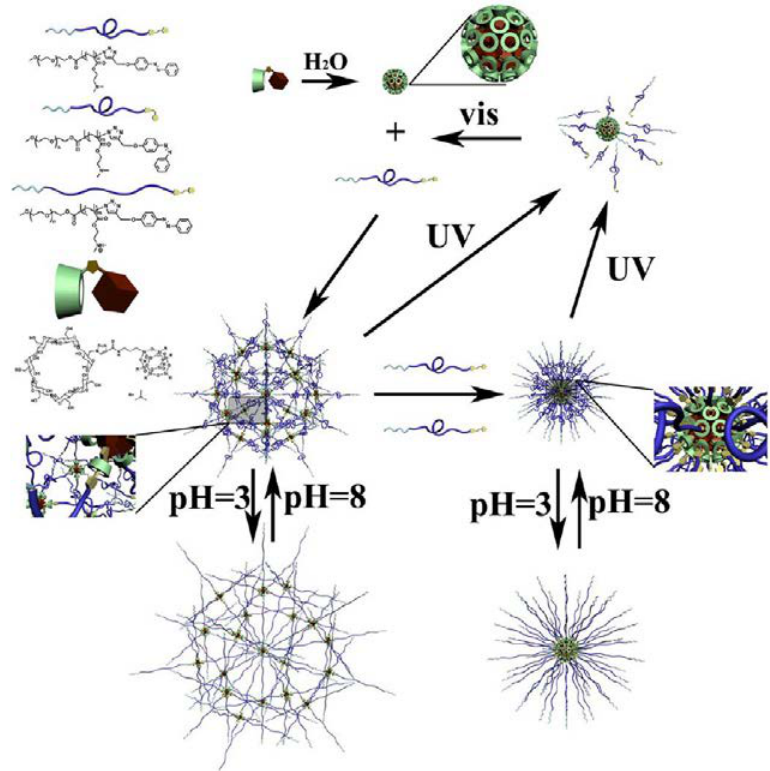
Figure 6. Proposed mechanism of the self-assembly process between PEG- b -PDMAEMA-azo (PPA) and mono-cyclodextrin substituted isobutyl polyhedral oligomeric silsesquioxane (mCPOSS) in aqueous solution. Reprinted with permission from [106]. Copyright (2014) American Chemical Society.